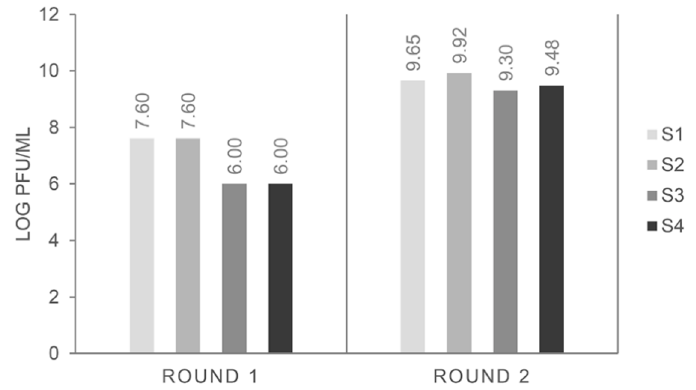
Figure 1. Phage titers obtained after each round of affinity selection against pistachio extract, following different biopanning strategies (S1–S4).